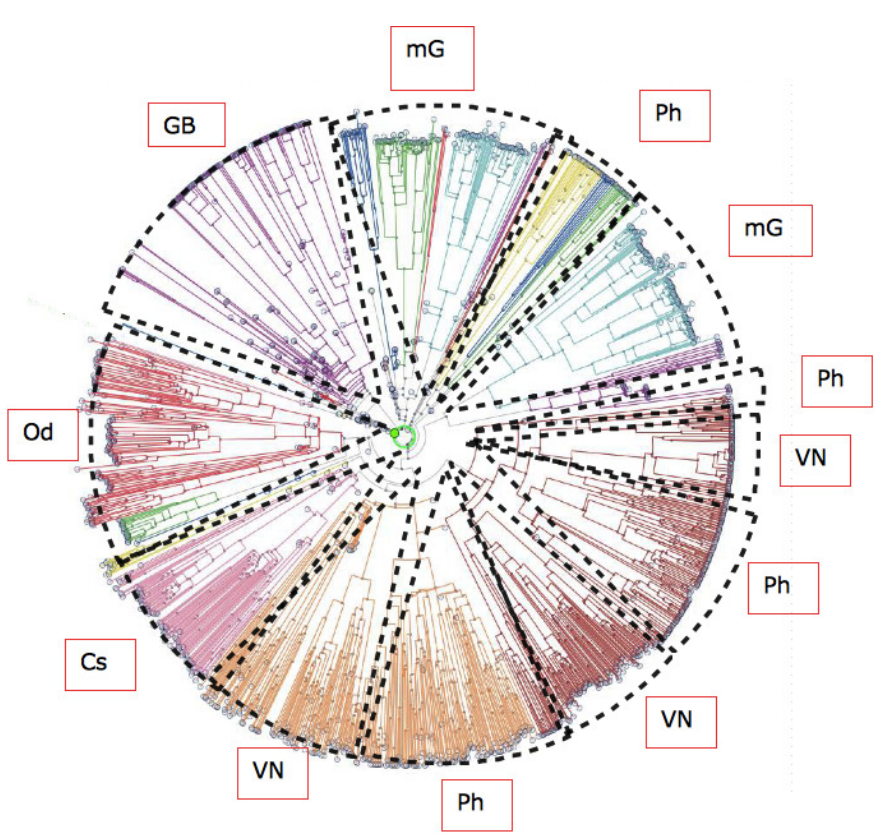
Figure 1: Treevolution radial phylogenetic tree for the 1,510 sequences under investigation [3]. Each outer leaf of each branch corresponds to a single sequence, tree colors represent families of descendant nodes. Subfamilies mG, Ph and Od are shown to cover several unrelated evolutionary